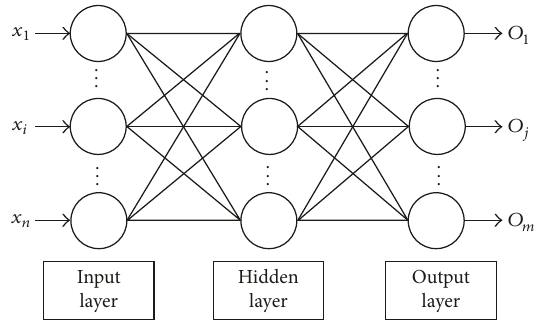
Figure 2: The structure of